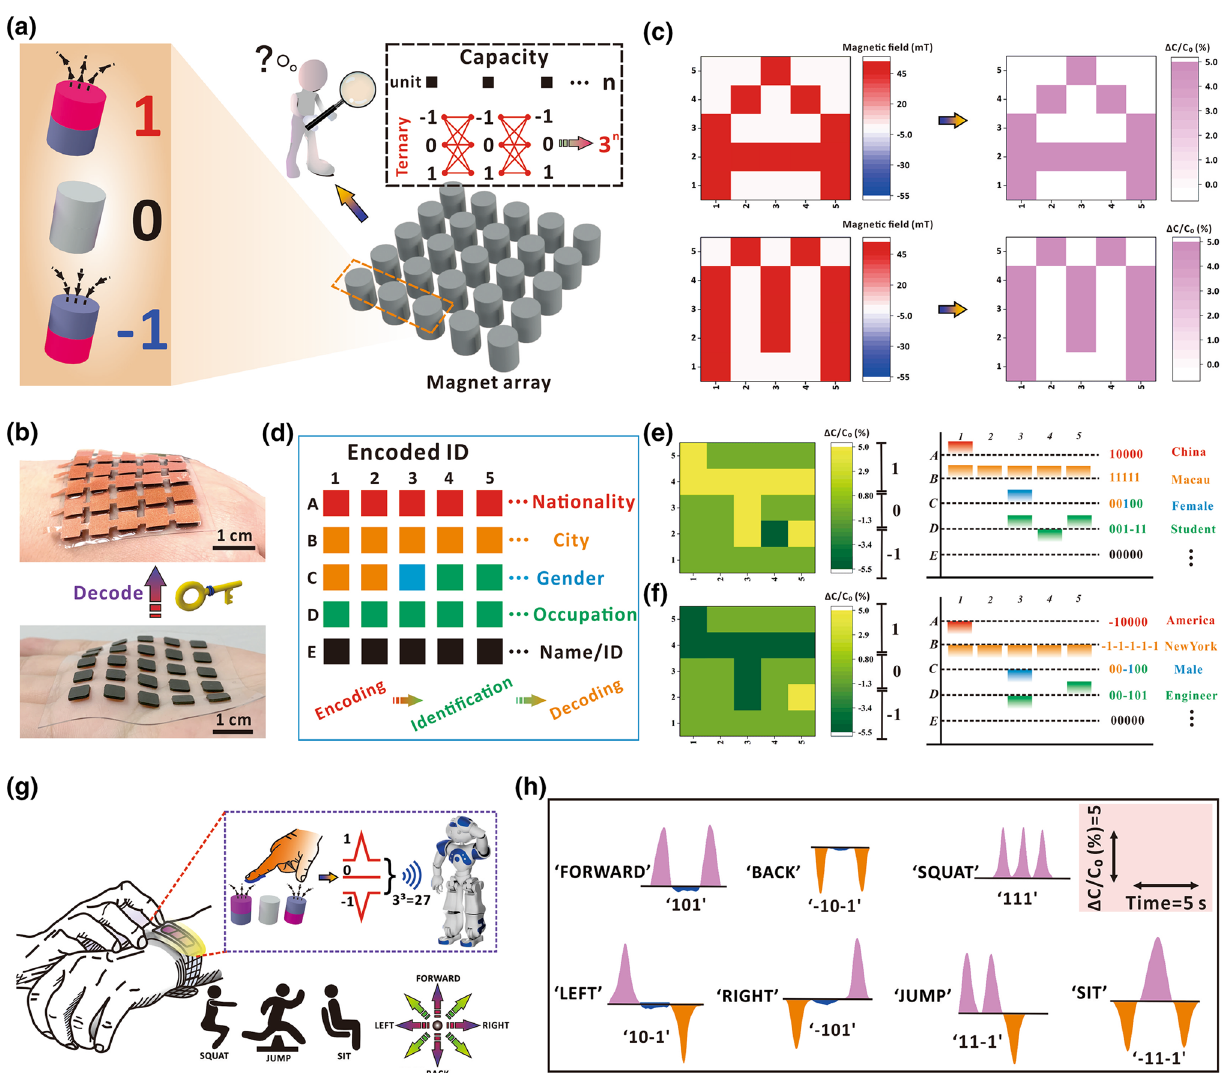
Fig. 5 a Schematic diagram of the ternary information coding system to encode cryptic information. b Demonstrated flexible magnet array and sensor array. c Mapping of magnetic fields customized in the flexible magnet array and the capacitance signals obtained by the sensor array with cryptic letters of ‘A’ and ‘M’. d Proposed cryptic ID recognition system. e–f Obtained capacitance signal mapping and the decoded ID informa- tion. To avoid the experimental errors, the relative capacitance variation below -2%, in the range of -2% to 1.5%, and over 1.5% was decoded as ‘-1’, ‘0’, and ‘1’, respectively. g Proposed high-capacity transmitter for outputting multi-bit coded control instructions based on our sensor. h 3-bit coded instructions transmitted by the